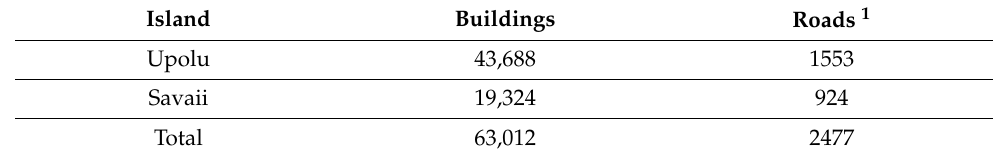
Table 1. Distribution of total buildings and road features in Upolu and